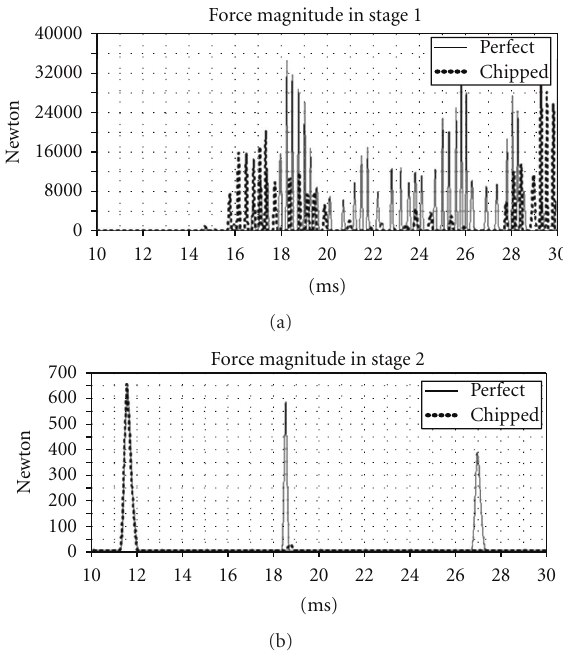
Figure 5: Comparison of the force magnitudes of Stage 1 and Stage 2 with initial conditions: input shaft, 167.5 rad/s; intermediate shaft, − 73.5 rad/s; output shaft, 12.5rad/s.